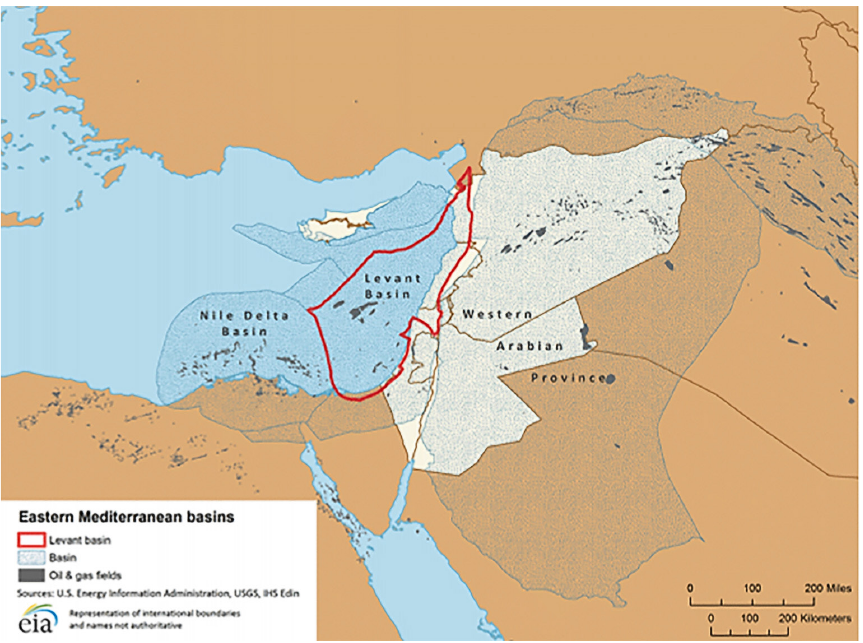
Fig. 2. Levant Basin in East Mediterranean Region (AEO